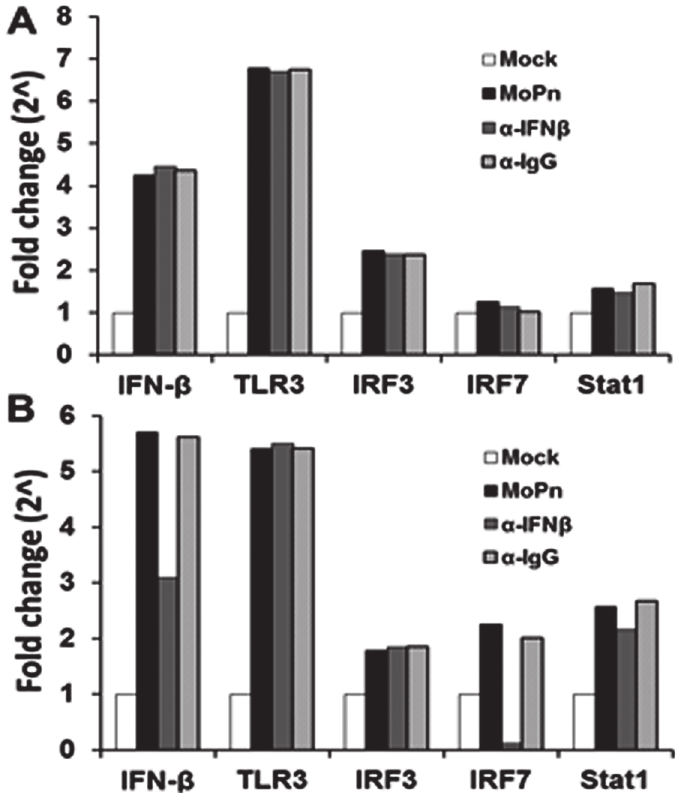
Fig 5. C . muridarum -induced IFN- β affects the gene expression levels of components found in the type-1 IFN signaling pathway. Bm1.1 cells were infected with 10 IFU/ cell C . muridarum , and the gene expression levels of IFN- β , TLR3, IRF3, IRF7, and Stat1 were measured by RT-qPCR after total cell mRNA was harvested at either early (12h) or late (24h) times post infection. (A) Transcription results of Bm1.11 OE cells harvested at 12h PI to measure the impact on transcription of candidate genes after cells were incubated from 4-to-12h PI in culture medium containing 1 μ g/ml of either IFN- β neutralizing antibody ( α -IFN β ) or isotype control antibody ( α -IgG). (B) Transcription results of these genes after cells were incubated in culture medium containing either antibody from 12-to-24h PI. The results shown are representative of three independent experiments; Fold change is compared to Mock-infected controls